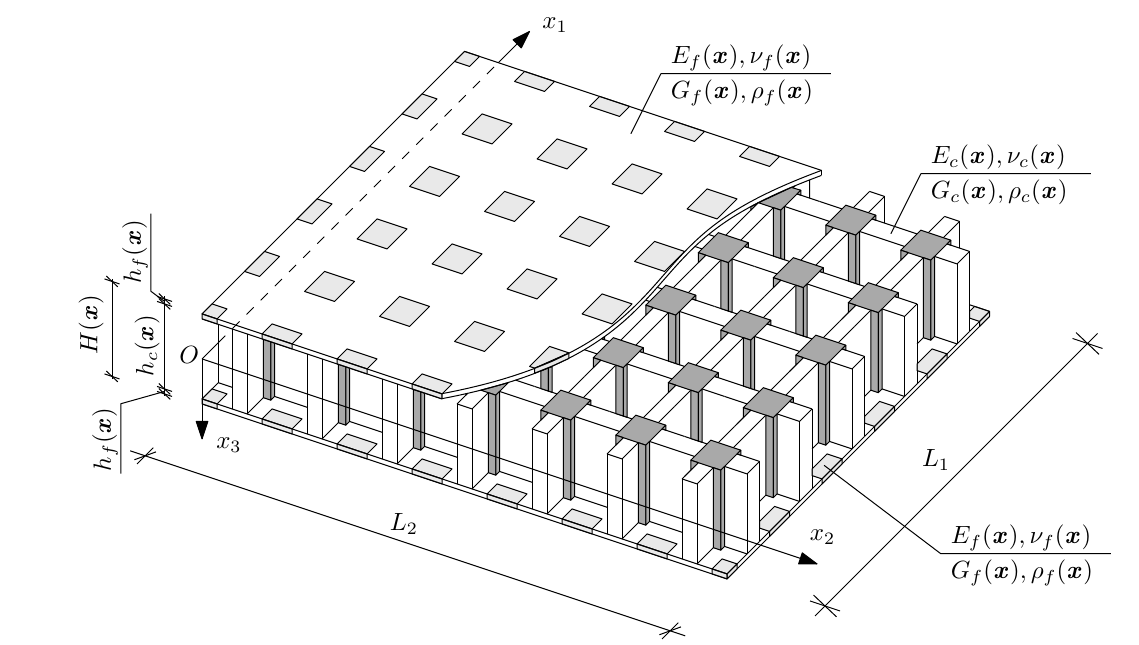
Figure 2. Sandwich plate with periodic